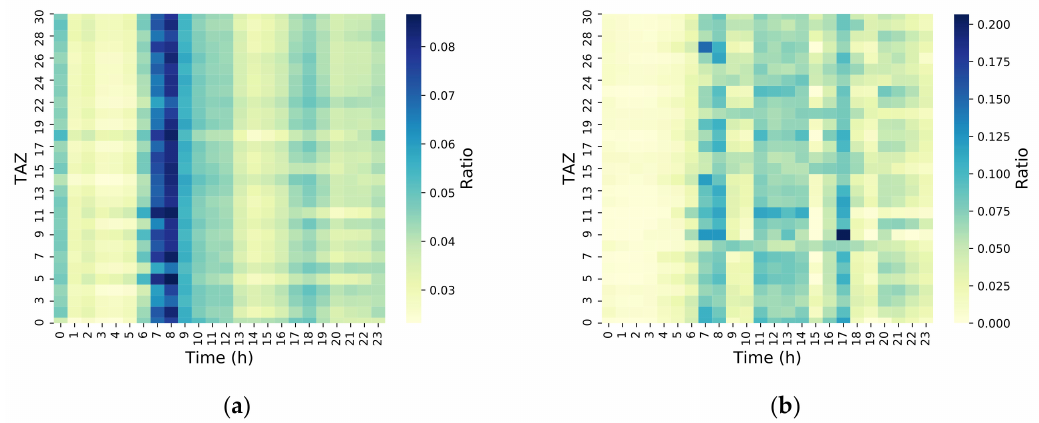
Figure 4. Hourly move population distribution for TAZ levels. ( a ) CS hourly move population distribution; ( b ) LPR hourly move population